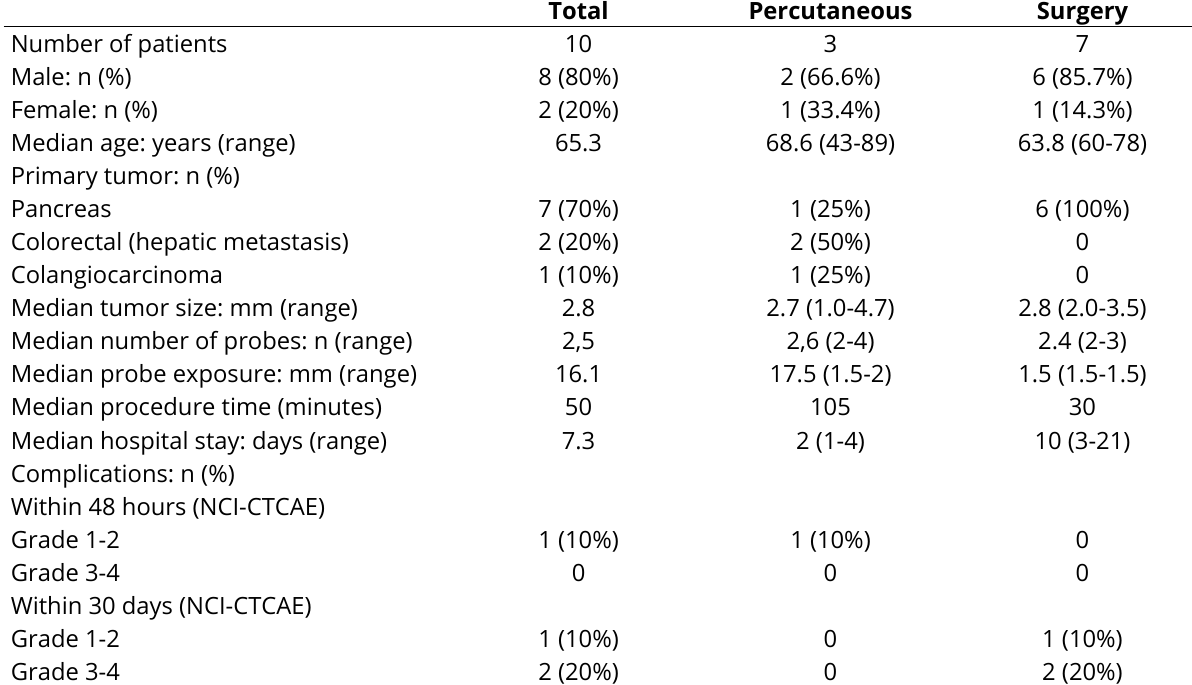
Table 3. Results summary.